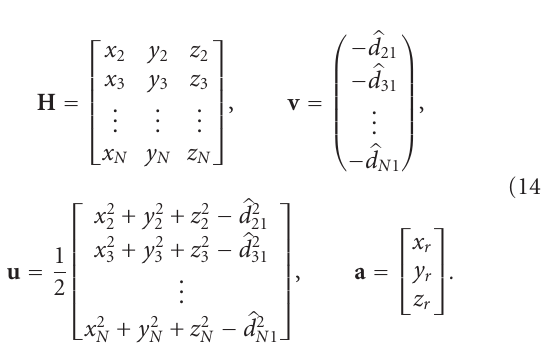
Figure 4: Root-mean-squared (RMS) localization error as a func- tion of the standard deviation of the distance measurements. (Two curves overlap and are not easily